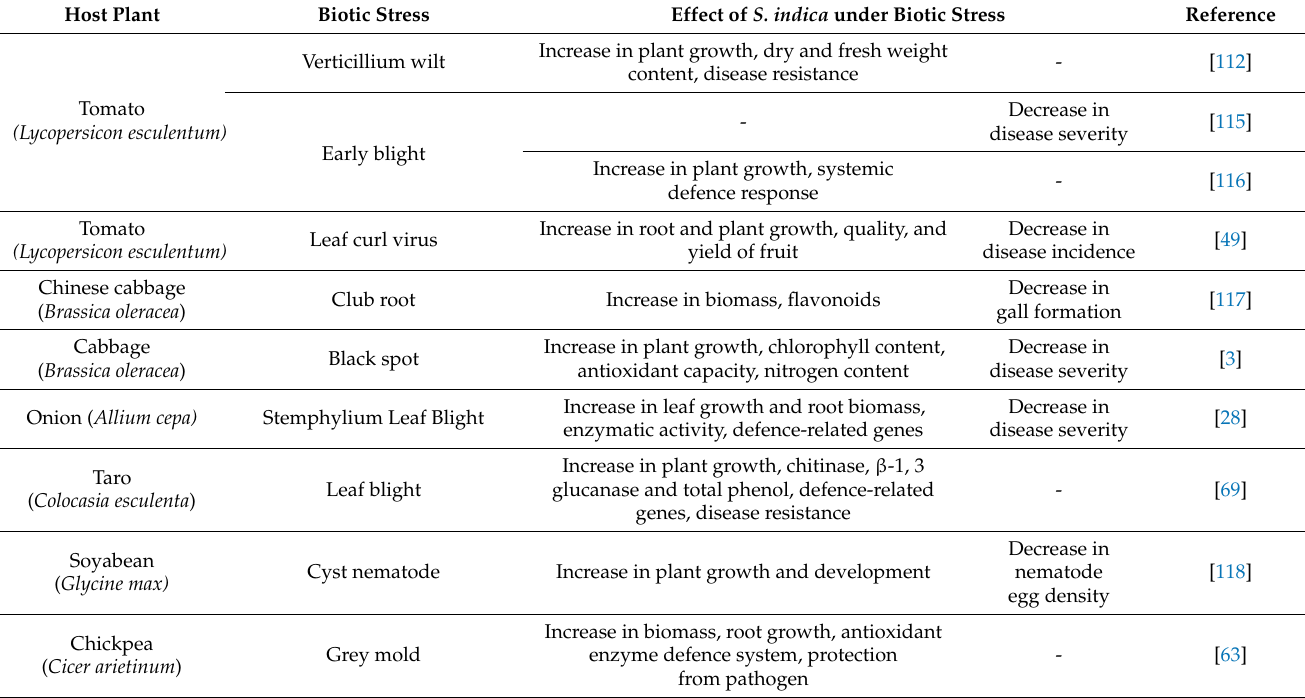
Table 2. Effects of S. indica on host plants under biotic stress